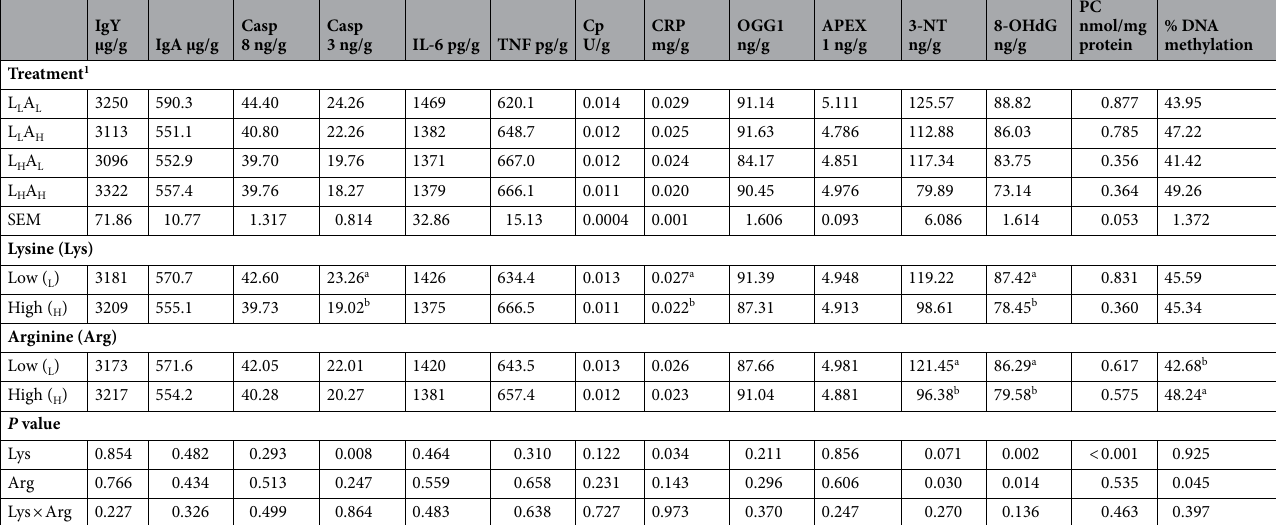
Table 5. Immunological, redox parameters and global methylation DNA in the intestinal wall of turkeys at 9 weeks of age. 1 L L A L diet with low Lys and low Arg levels; L L A H diet with low Lys and high Arg levels; L H A L diet with high Lys and low Arg levels; L H A H diet with high Lys and high Arg levels. IgA: immunoglobulin A; IgY: immunoglobulin Y; Casp 3: caspase 3; Casp 8: caspase 8; IL-6: interleukin 6; TNF-α: tumor necrosis factor alpha; Cp – ceruloplasmin; CRP: C-reactive protein; OGG1: oxoguanine glycosylase; APEX-1: endonuclease 1; 3-NT: 3- nitrotyrosine; 8-OHdG: 8 - hydroxydeoxyguanosine; PC: protein carbonyl. a,b Values in same column with no common superscripts denote a significant difference (P ≤ 0.05).